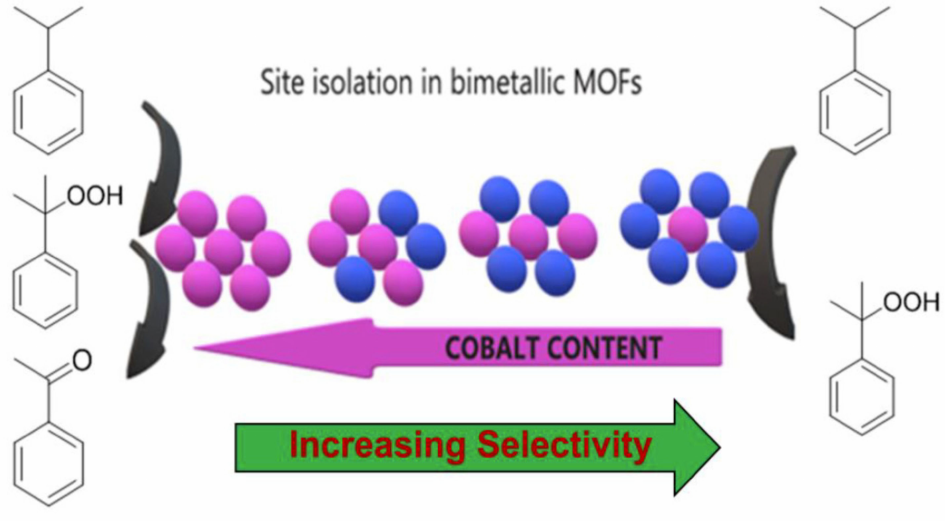
Figure 4. Influence of Co 2+ ions in the aerobic oxidation of cumene using Co 5 Ni-BTC MOFs. Repro- duced with permission from [46].